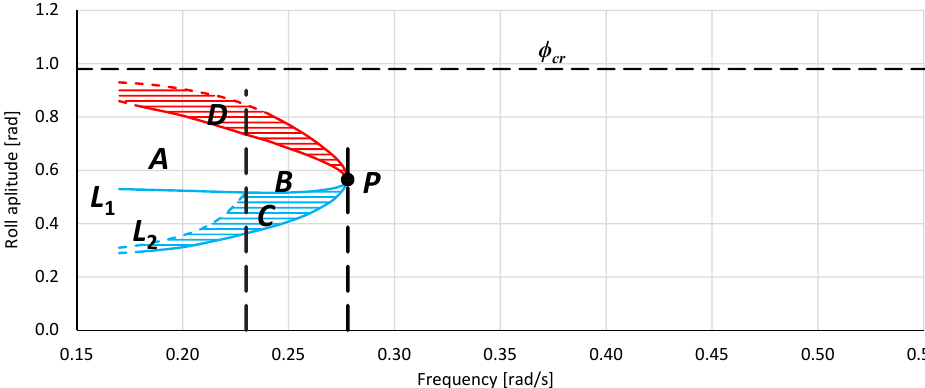
Figure 5. Areas of bistability and unstable solution of the mathematical model of rolling for the LNG carrier ( T = 7.50 m, GM 0 = 4.00 m).